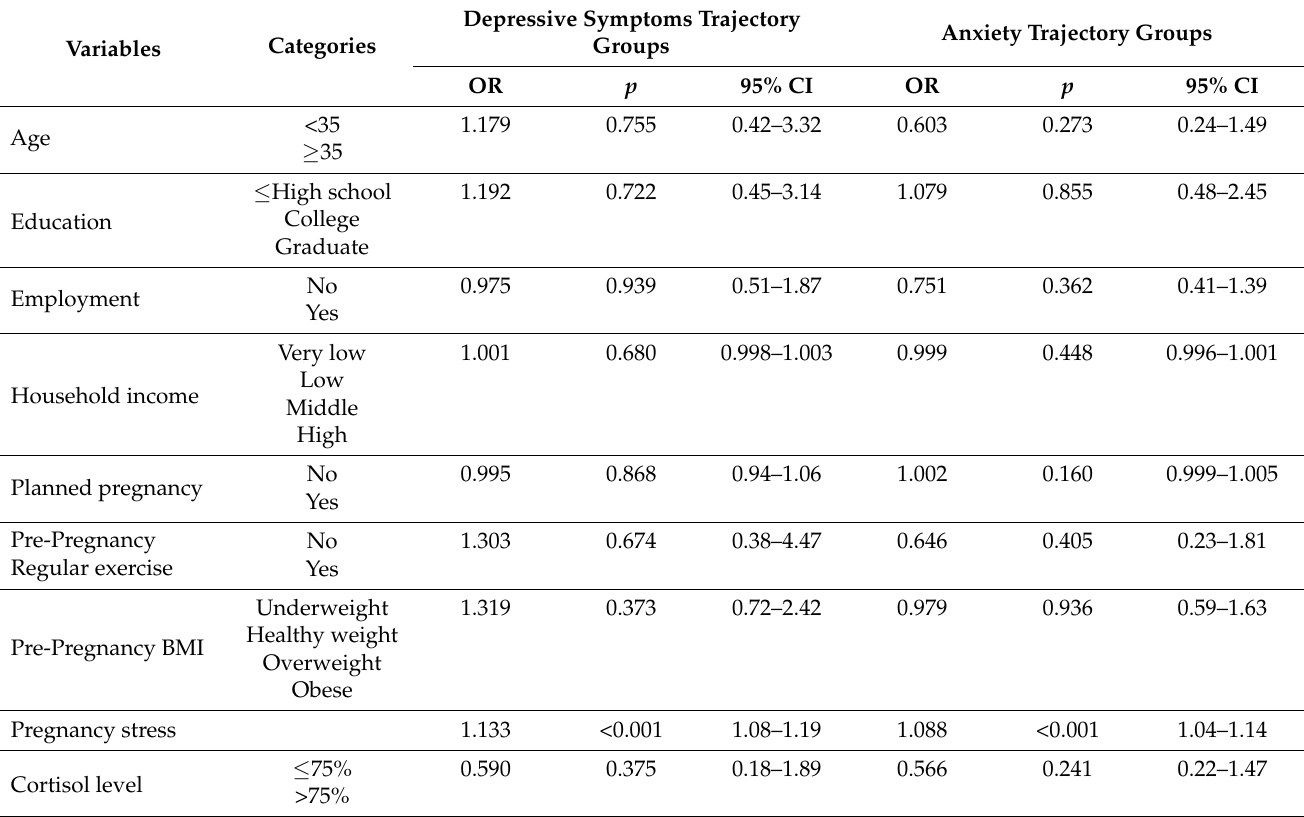
Table 4. Factors associated with predictors of the latent trajectory groups for depressive symptoms and anxiety.